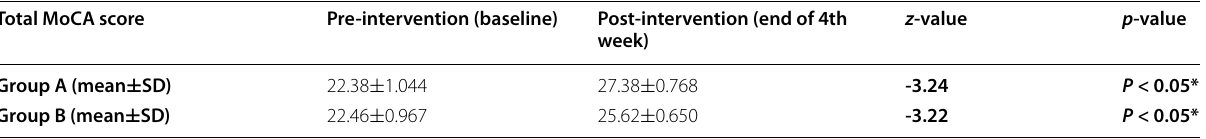
Table 2 Comparison of mean and standard deviation (SD) of MoCA score of pre (baseline) and post-intervention (end of 4th week) among groups A and B